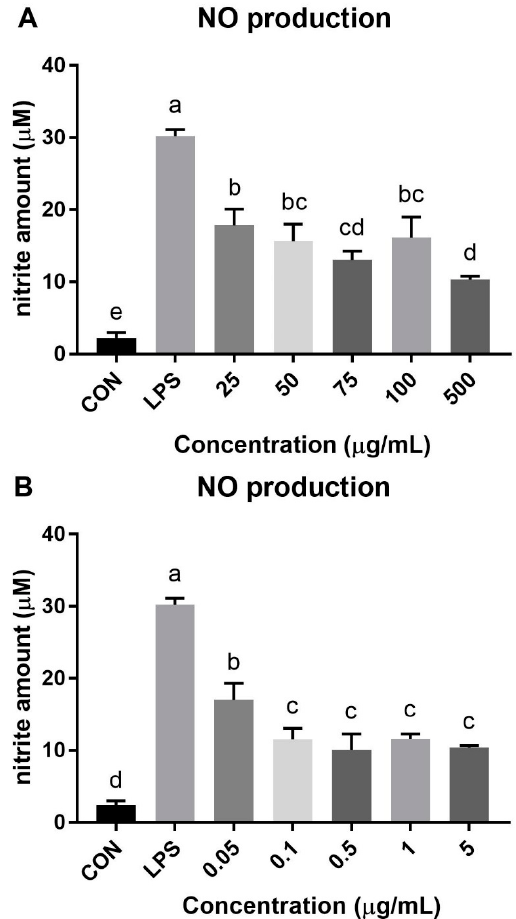
Figure 2. Reduce of NO production on lipopolysaccharide (LPS)-induced (1 µ g / mL) RAW 264.7 cell line. ( A ) The 80% methanol extract of defatted mealworm powder; ( B ) unsaponifiable lipid of mealworm oil. Different superscripts (a–e) represent significant differences at p < 0.05.